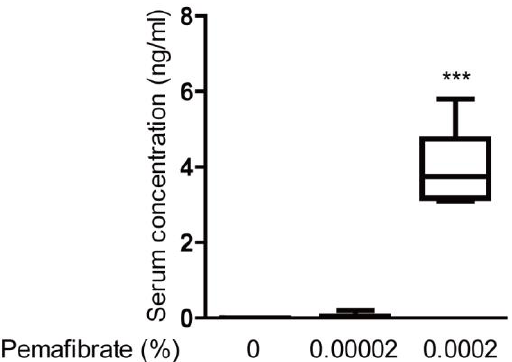
Figure A1. Detection of serum pemafibrate concentration in the STZ-induced diabetic mouse model. Quantitative analysis showed that serum pemafibrate concentration was constantly detectable after administration of 0.0002% pemafibrate in STZ-induced diabetic mice ( n = 6 per group). *** p < 0.001. The graph is presented as median with interquartile range, the 25th and 75th percentile. The data were analyzed using one-way ANOVA followed by a Bonferroni post hoc test.